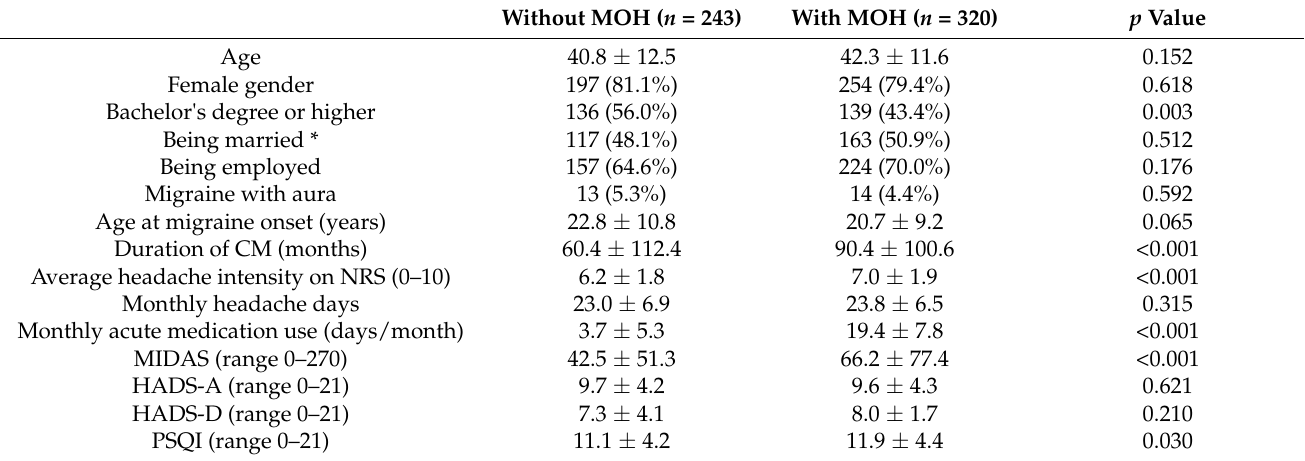
Table 1. Clinical characteristics in chronic migraine patients with and without medication- overuse